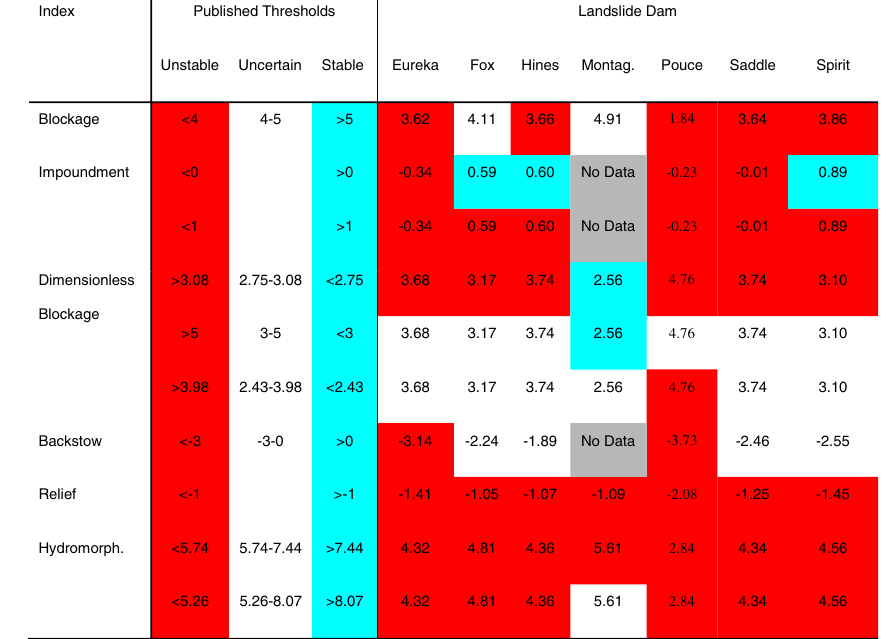
Red background indicates “ unstable ” , blue indicates “ stable ” , and white indicates "uncertain"